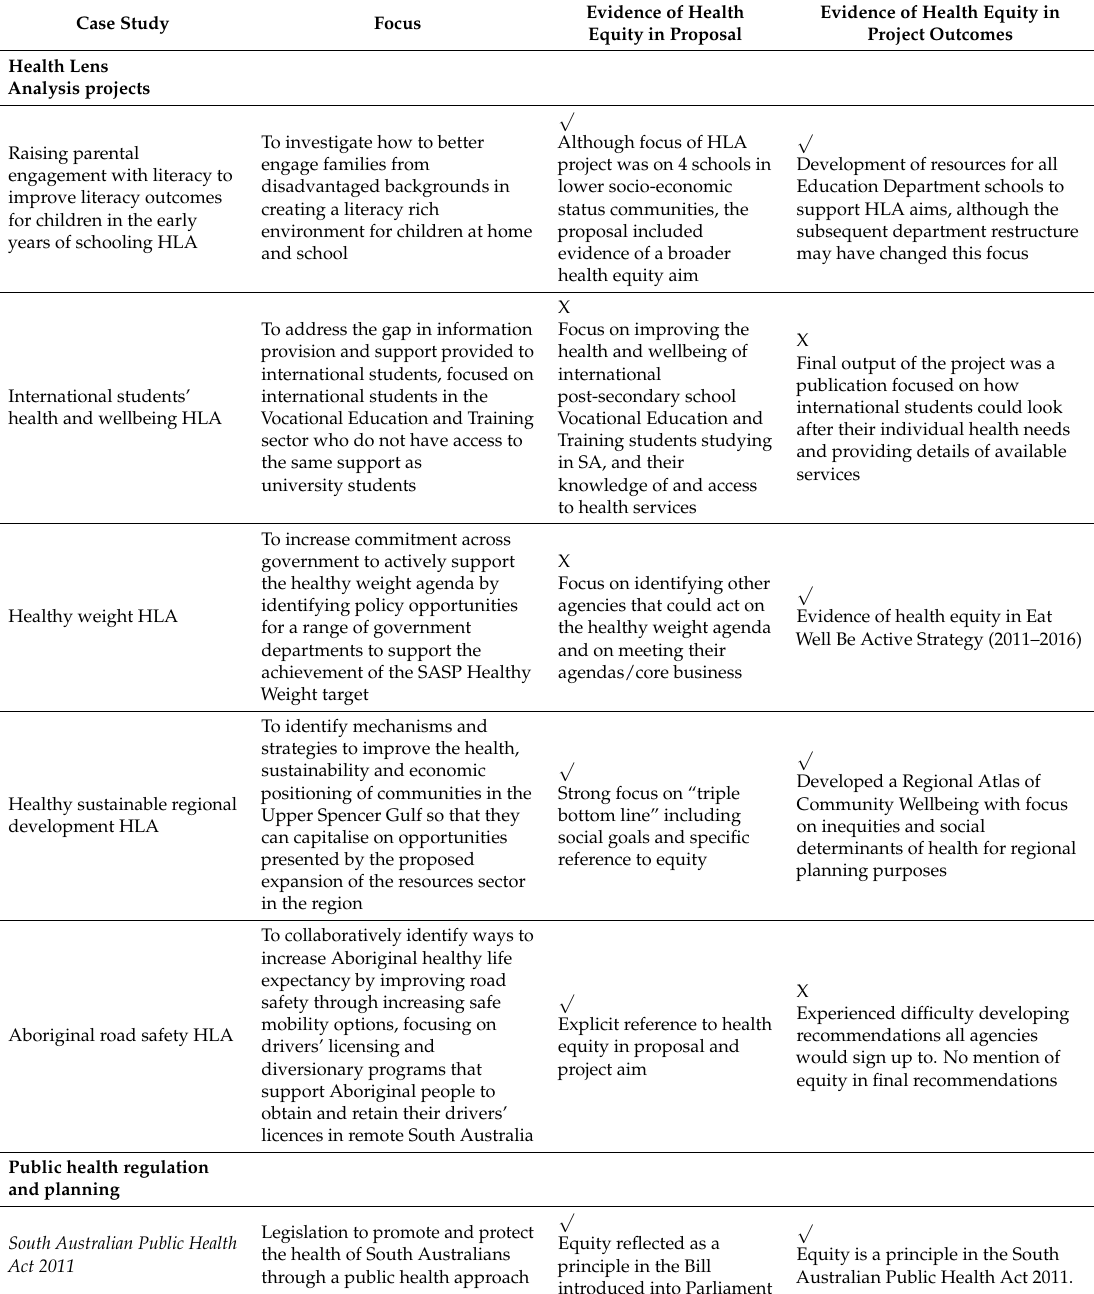
Table 4. Health Lens Analysis (HLA) research case studies and subsequent HiAP-based